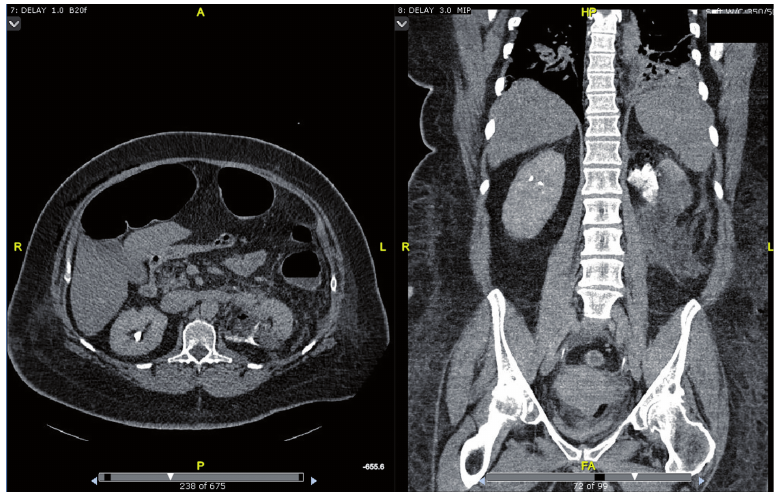
Figure 1 - Axial and coronal CT images documenting left urine leak after